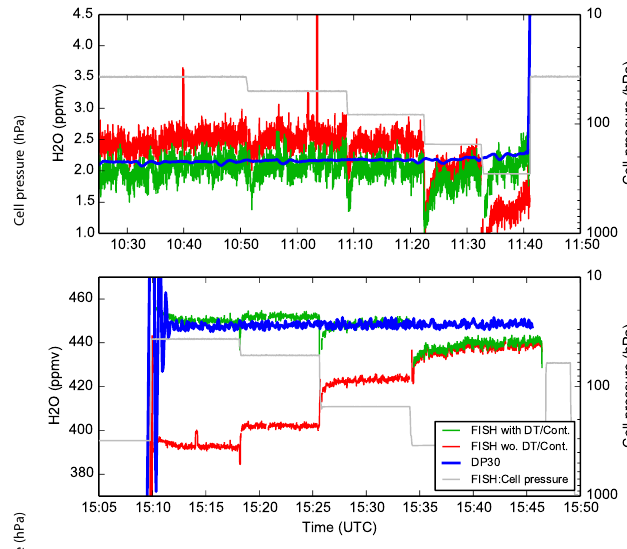
Figure 5. Lowest and highest level of the same calibration shown in Fig. 4, but calculated with the modified calibration equations (green line). For more detail see